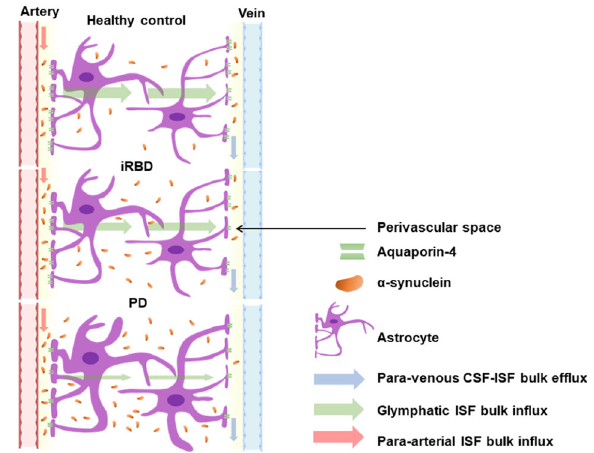
Fig. 5 A proposed possible mechanism underlying the α -syn deposition and glymphatic system. The glymphatic system is a waste drainage system that is driven by periarterial ISF bulk in fl ux (red arrow), glymphatic ISF bulk in fl ux (blue arrow), and perivenous CSF-ISF ef fl ux (green arrow). In prodromal (iRBD) and the early stage of PD, the deposition of α -syn may reduce glymphatic clearance